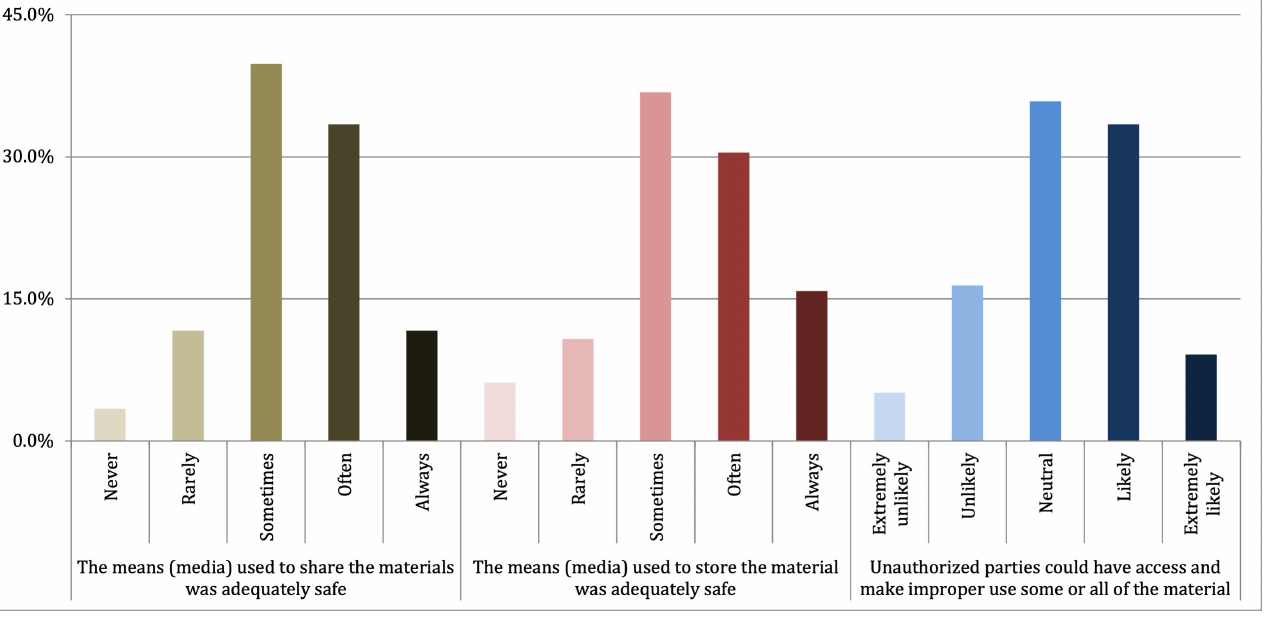
Figure 5. Indonesian scientists’ perceptions of the safety of digital materials.